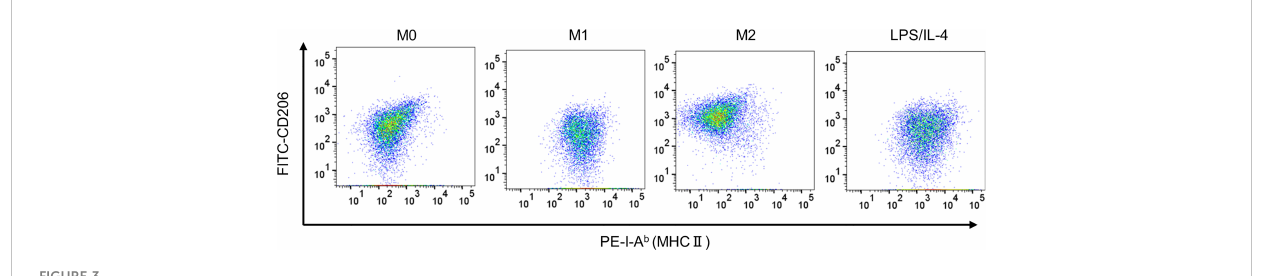
FIGURE 3 LPS/IL-4-induced macrophages show a homogeneous population. Bone marrow-derived macrophages were prepared and stimulated with either LPS, IL-4, or LPS plus IL-4 for 24 h. Flow cytometric analysis was performed to examine the expression of I-A b and CD206 gated on 7-AAD − CD45 + CD11b + F4/80 + . Representative dot plot data are shown.